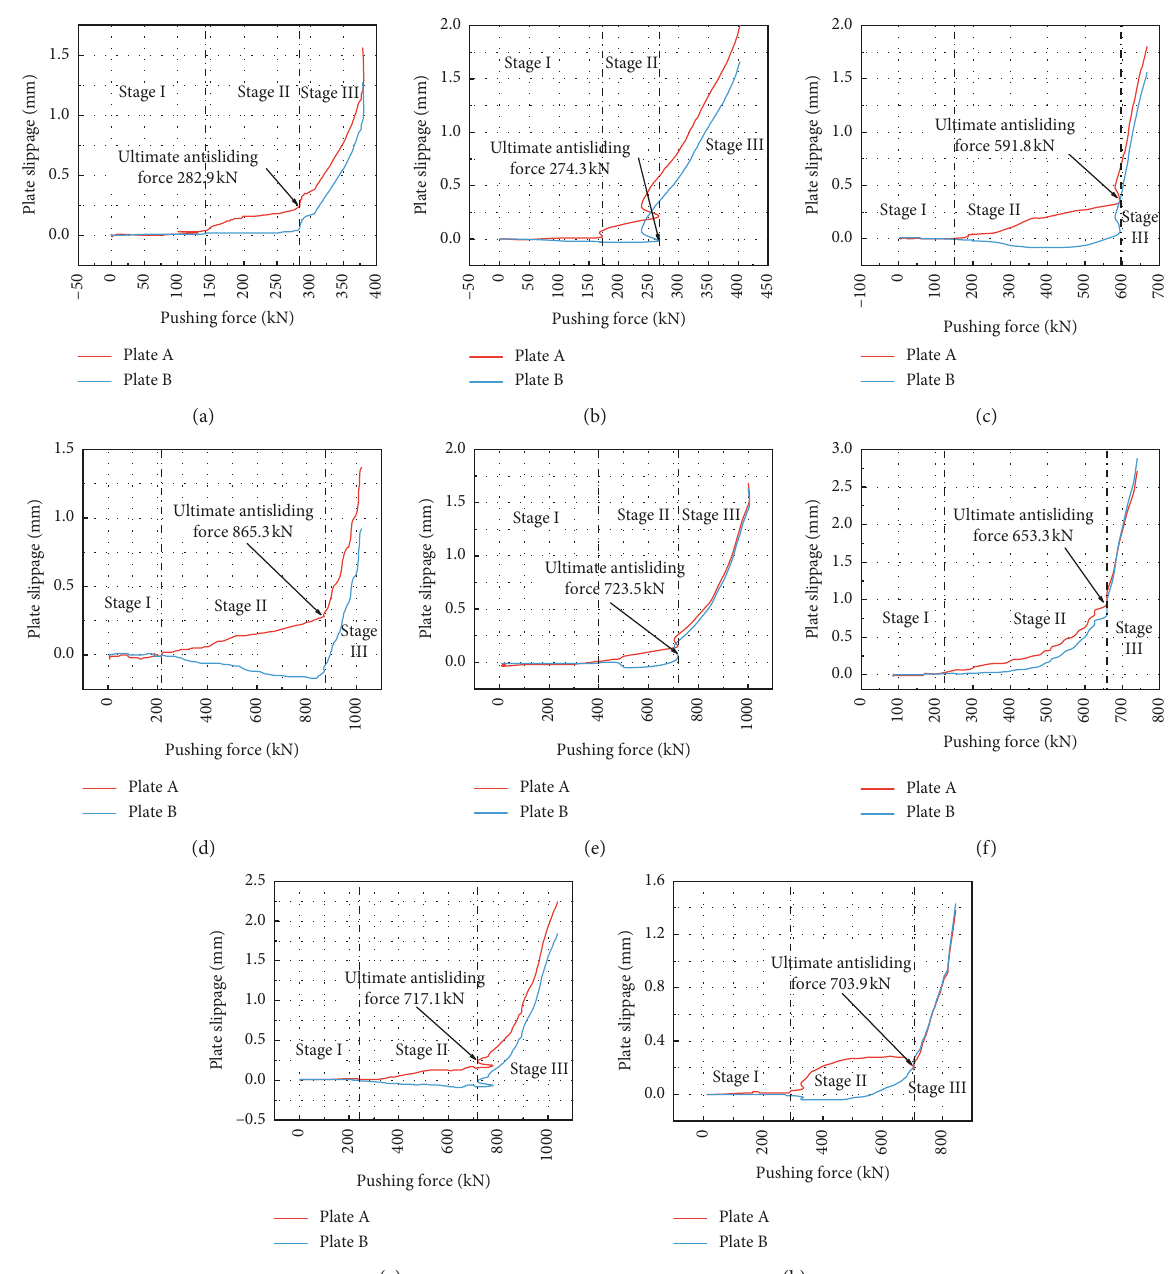
Figure 16: Pushing force vs. plate slippage curve. (a)